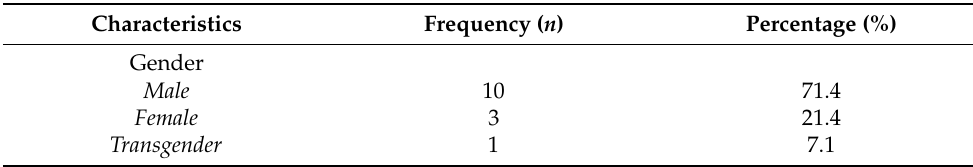
Table 6. Socio-demographic profile of the qualitative